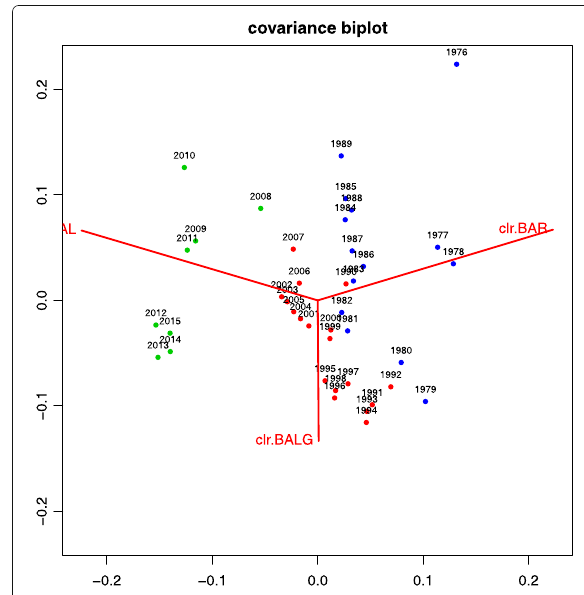
Fig. 4 Covariance Biplot. BALG-BAR-VAL traffic composition. The projection represents 100% of variance. The longitude of the rays is proportional to the variability of the clr.variable. Blue dots corresponds to the period 1976–1989 (before containerization boom), red dots correspond to the period 1990–2007 (before the crisis) and green dots correspond to the period